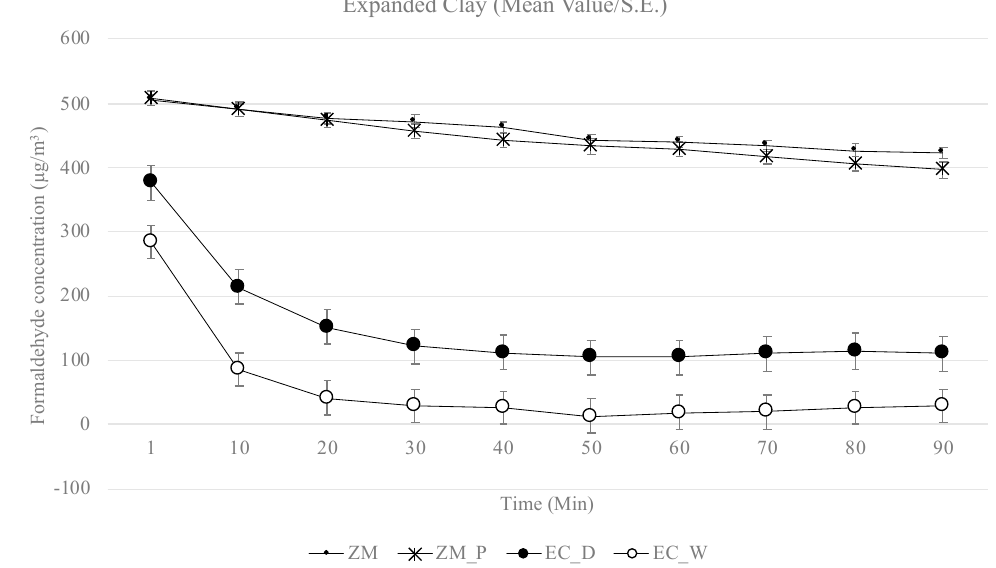
Figure 4. Measured formaldehyde concentration (( µ g/m 3 )/h) when expanded clay samples were tested: zero measurement (ZM), zero measurement with the plastic pot (ZM_P), dry expanded clay (EC_D), wet expanded clay (EC_W). Data means ± SE, n = 3.